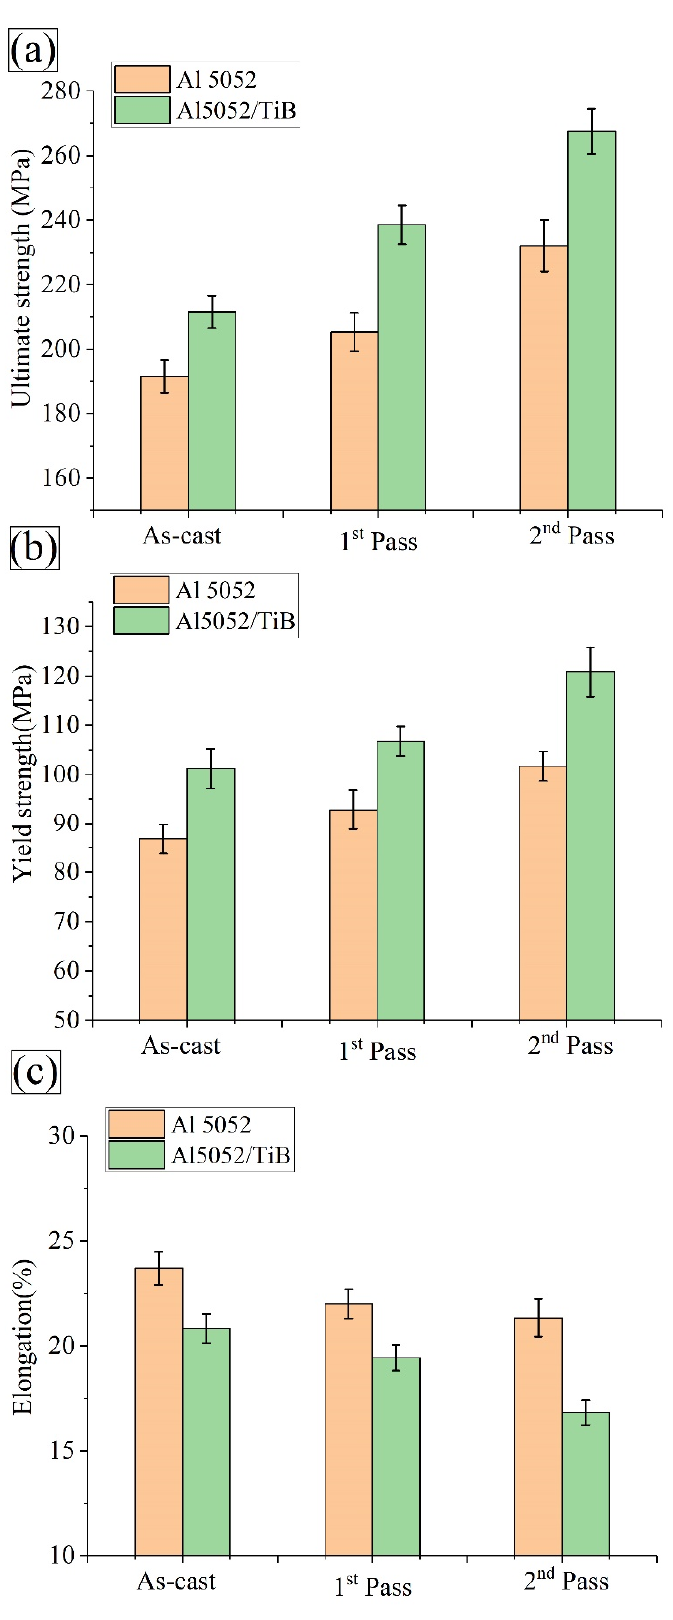
Figure 12. ( a ) Ultimate strength, ( b ) yield strength, and ( c ) elongation of Al 5052 and Al 5052/TiB samples for one and two passes of FSP.